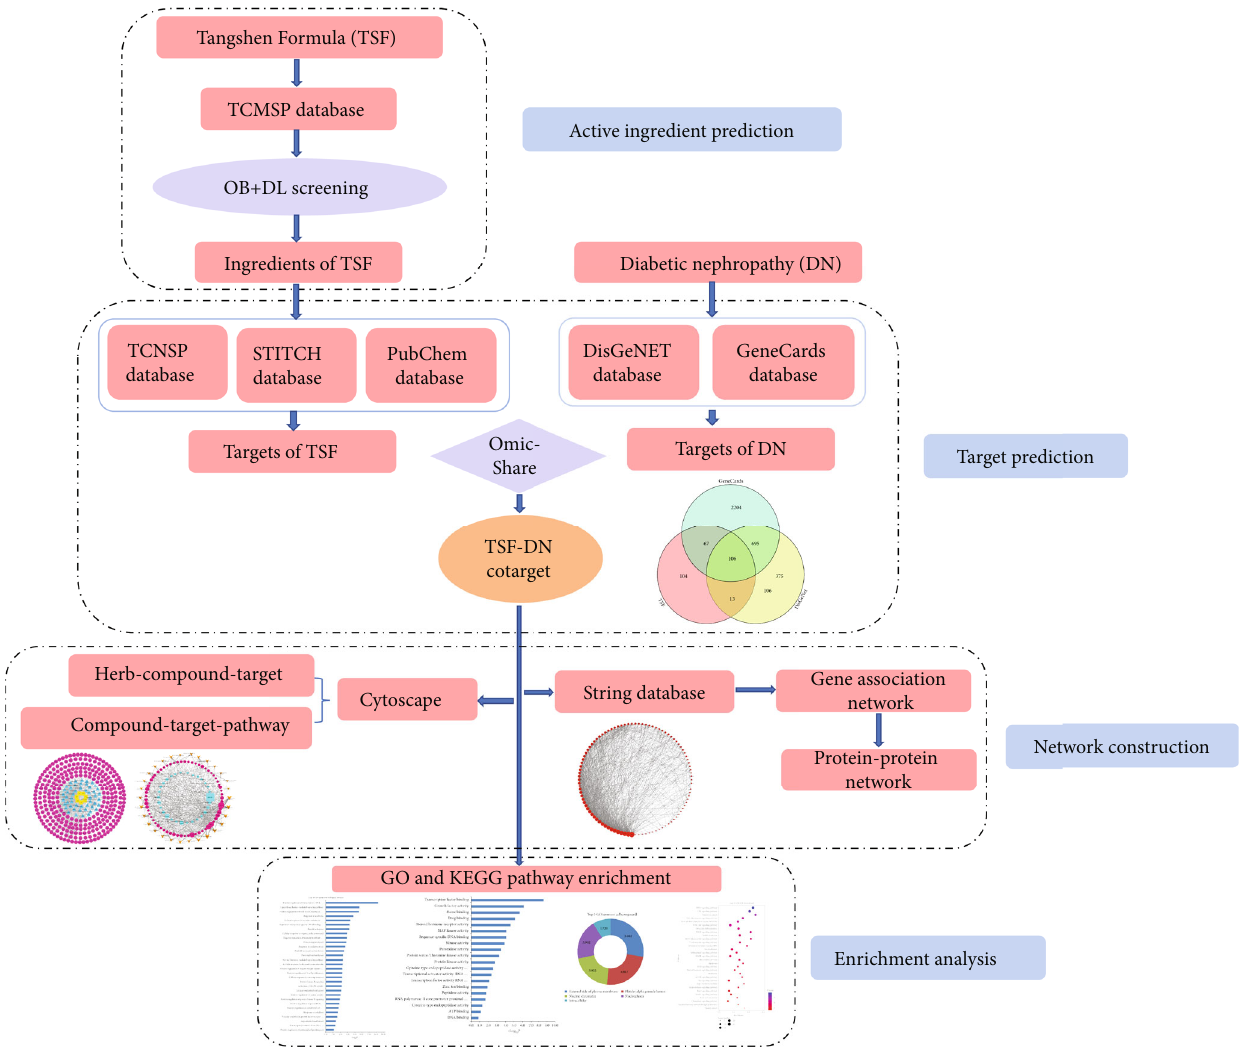
Figure 1: The whole framework based on network pharmacology for deciphering active ingredients and pharmacological mechanism of Tangshen Formula (TSF) acting on diabetic